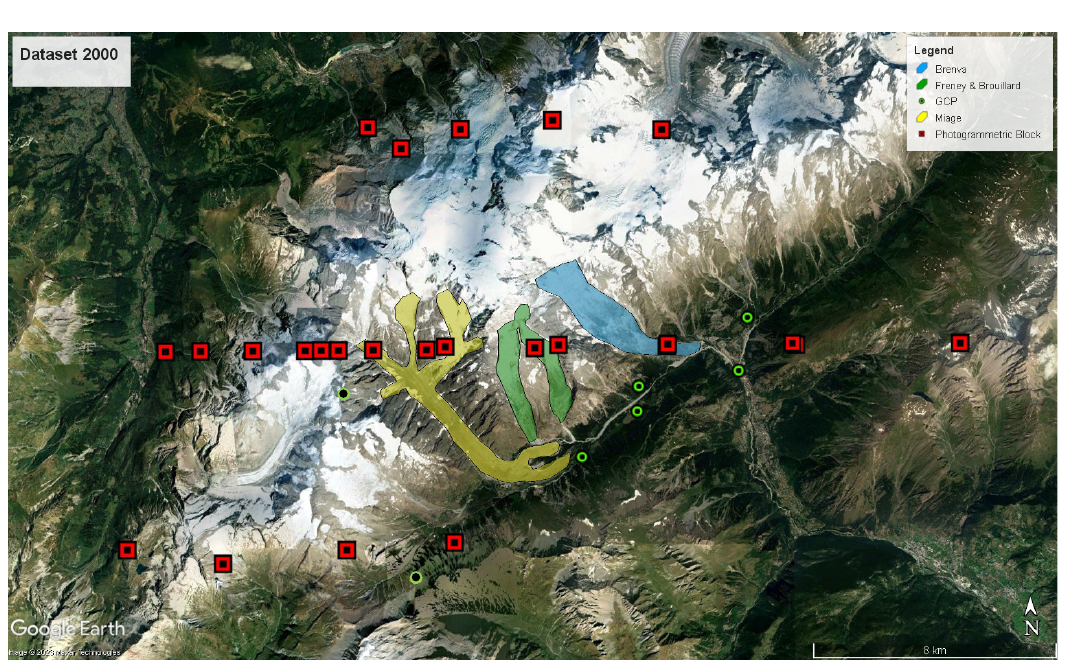
Figure 2. Satellite view of the area under investigation including: glacier outlines (see legend), ground control points (GCPs), and locations of aerial photos from the Dataset 2000 (acknowledgements to Google Earth ® for the background satellite